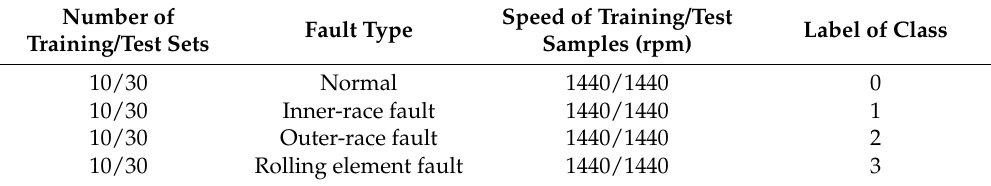
Table 6. The description of the